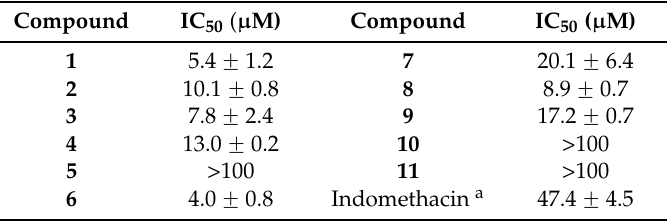
Table 2. Inhibitory Effects on NO Production of the Triterpenes from Acorns.